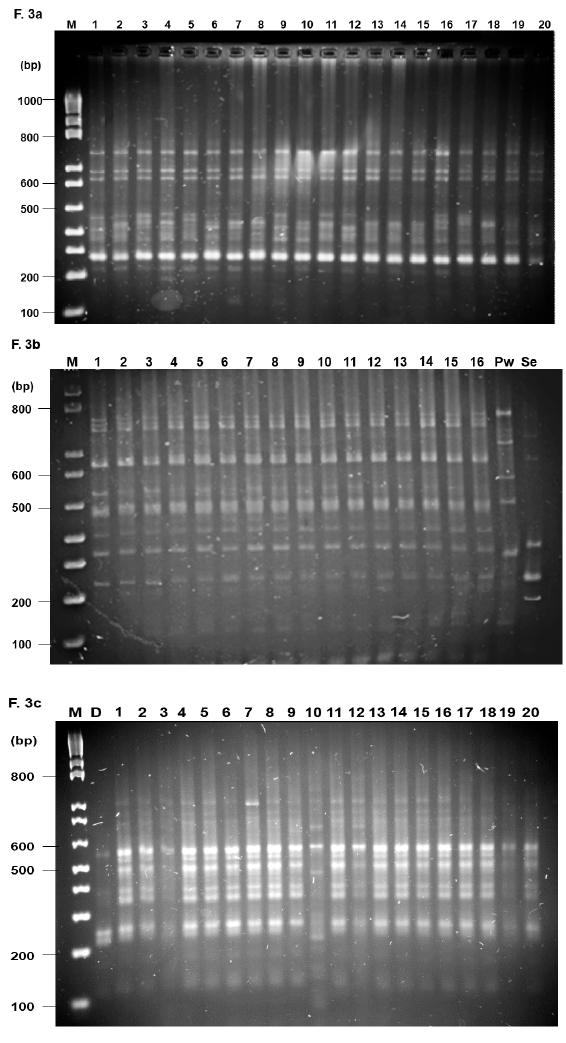
Figure 3. RAMP polymorphism of L. graveolens after different in vitro treatments. ( a ) Agarose gel electrophoresis for primer combination 5 (OPB-08 and ARS-02). Plants obtained from 20 seeds of L. graveolens , collection A (lines 1–9), collection R (lines 10–13), collection V (lines 14–20). ( b ) Agarose gel electrophoresis for primer combination 2 (OPB-12 and ARS-08). Plants obtained from genotype B (mother plant, lane 1), lane 2–6 first subcultivation, lane 7–11 second subcultivation, lane 12–16 third subcultivation, Se: Sechium edule and Pw: Paulownia elongata as a control. ( c ) Agarose gel electrophoresis for primer combination 5 (OPB-07 and ARS-02). Lane 1–20 plants obtained after the mutagenic treatment (0.1% EMS, 2h exposure), D: control plant.